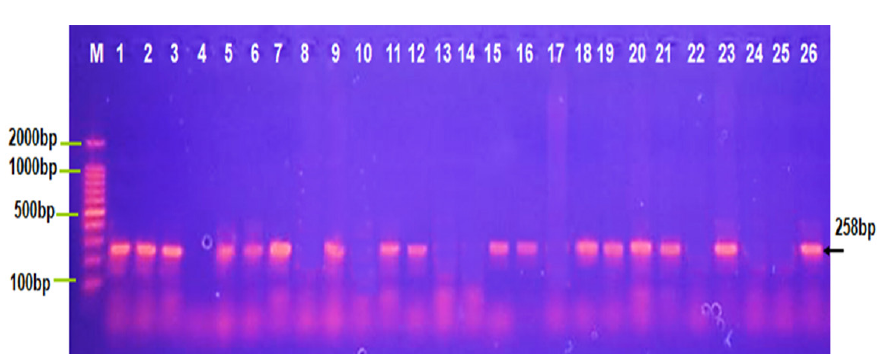
Fig. 2. Agarose gel electrophoresis image that shown the PCR product of a virulence factor gene ( iss ) at (258 bp) in different bacterial isolates. Where M: Marker (2000-100bp), lane (1-5) E . coli , lane (6-10) K . pneumonia , lane (11-15) Salmonella typhi , lane (16-20) Shigella dysentery , lane (21-22) Serratia marcescens and lane (23-26) Proteus vulgaris